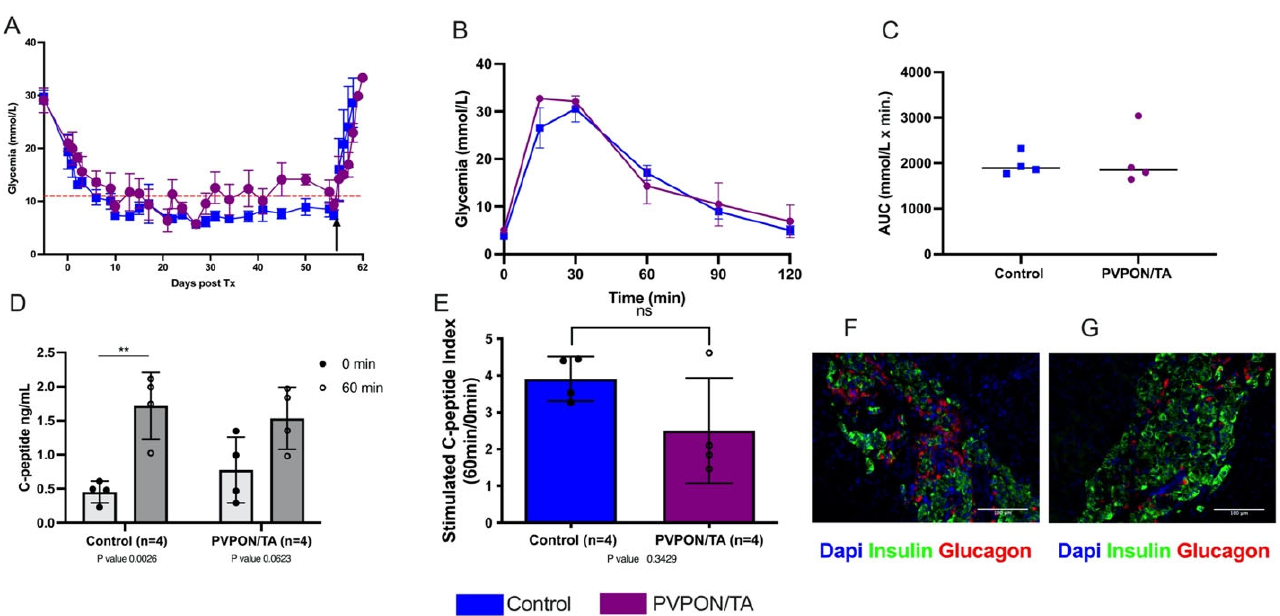
Figure 4. PVPON/TA-coated human islets retain their ability to restore euglycemia post-transplant. Post-transplant non-fasting blood glucose measurements of Rag -/- mice transplanted with either 1500 non-coated ( n = 4) or PVPON/TA-coated ( n = 4) human islets equivalent ( A ). Arrow represents survival nephrectomy. Blood glucose profiles ( B ) and AUC ( C ) following intraperitoneal glucose tolerance testing 30 days post-transplant. Animals from the control group ( n = 4, blue) demonstrated similar glucose clearance compared to PVPON/TA-coated islet recipients ( n = 4, purple) ( p > 0.05, two-tailed t -test). During the glucose tolerance test, samples were taken for human C-peptide levels ( D ). C-peptide basal and stimulated measurements from the control group were significantly different (** p < 0.01, two-tailed t -test). C-peptide levels from PVPON/TA recipients did not differ between basal and stimulated levels. Stimulated C-peptide index similar between control and PVPON/TA recipients ( E ). Immunohistochemistry of human islet PVPON/TA-coated ( F ) and control ( G ) grafts. Data represented as mean ± SEM. Scale bars represent 100 µ